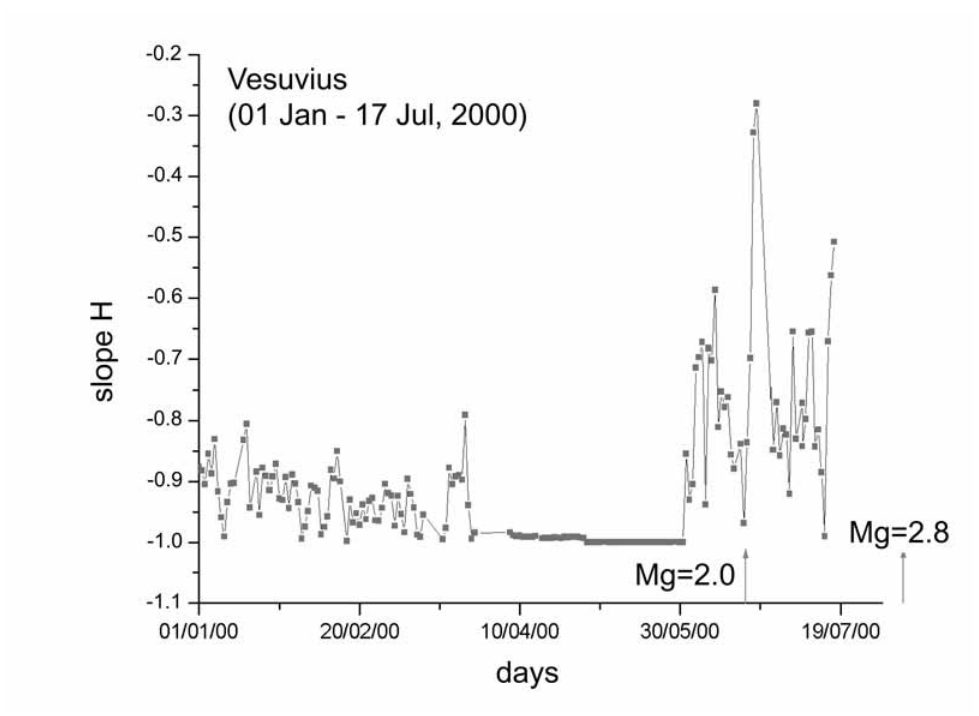
Fig. 5. Daily estimates of H versus time of the AE collected on Vesuvius during January through June 2000 A.D. See